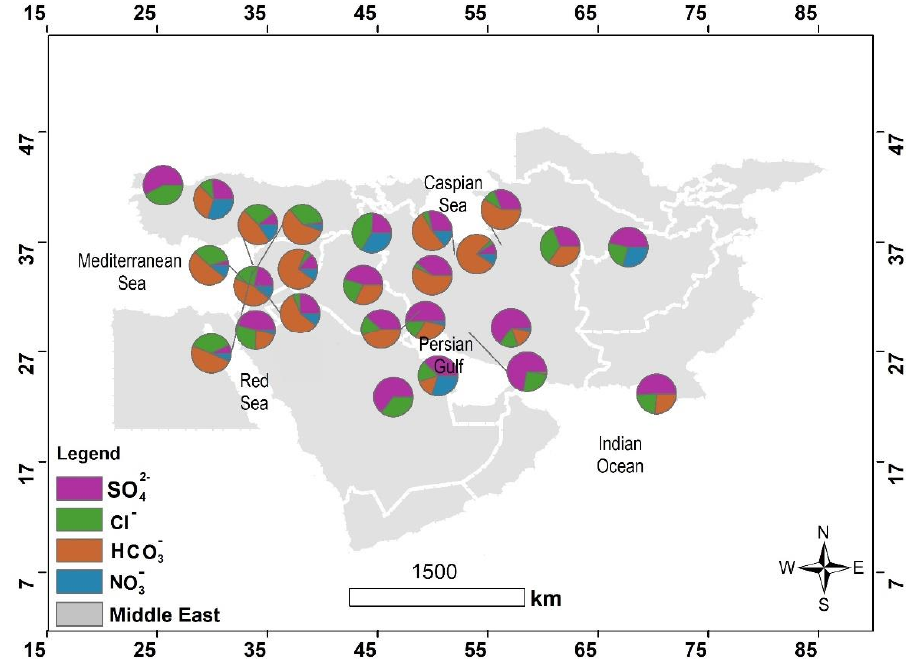
Figure 5. The variations in the major anions in the precipitation at the studied stations across the Middle East.